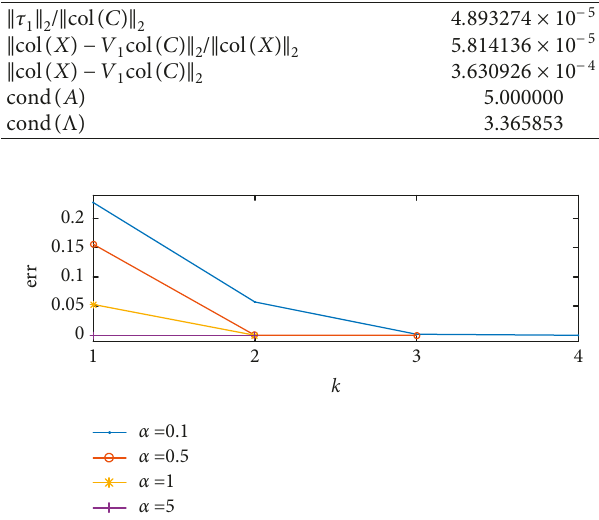
Figure 1: Error versus iteration number k for Example 2 when ( p,t ) � ( 10 , 10 )